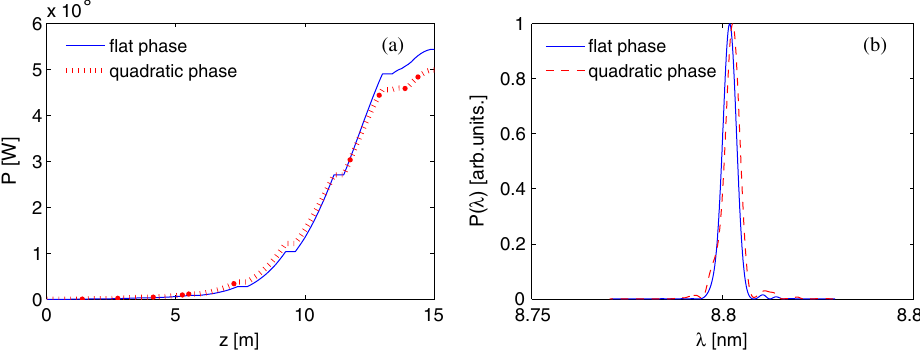
FIG. 17. 30th harmonic radiation performances of EEHG with subharmonic modulator resonant at 1320 nm for the 80 fs seed laser pulses with flat phase (blue line) and quadratic phase (red dashed line): (a) FEL gain curves; (b) spectra at